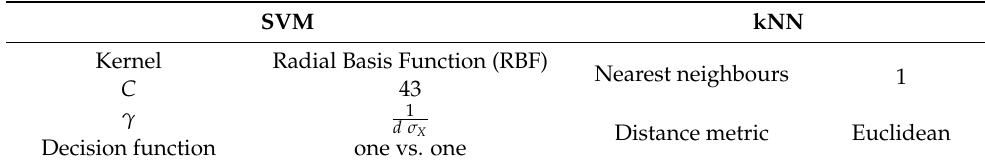
Table 3. Hyperparameters for the SVM and kNN